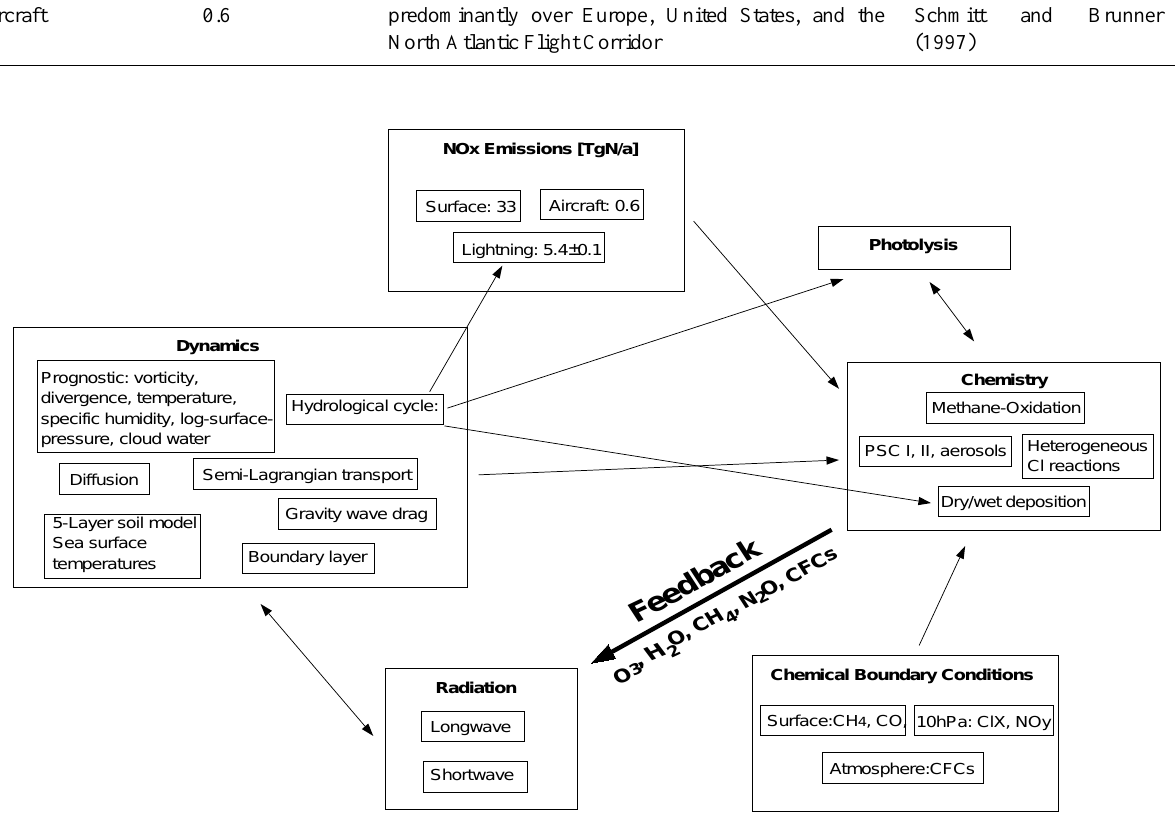
Fig. 1. Schematic overview of the processes involved in ECHAM4/CHEM, particularly the coupling between chemistry and climate. The feedback of chemistry to dynamics through its influence on radiation is highlighted (bold